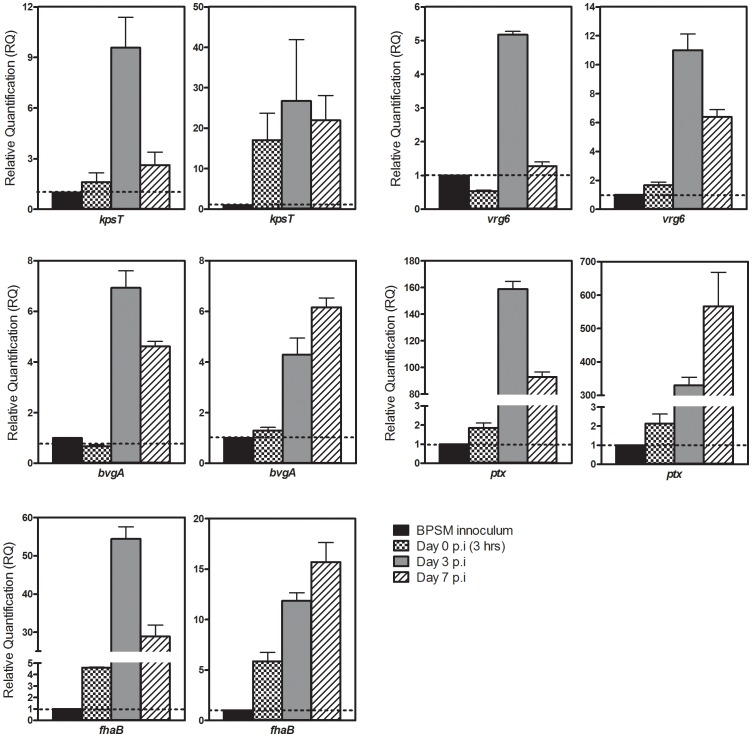
Relative transcriptional activity of vrgs and vags in BPSM bacteria recovered from mice lungs versus in vitro BPSM grown in virulent phase.Mice were infected intranasally with approx. 5×106 CFU of BPSM and the bacteria were recovered from the mice lungs at different time points (3 hours, day 3 and day 7 p.i.). Bacterial RNA extracted and purified from group of 4 mice were pooled and subjected to real-time PCR analysis using primers mapping in the kpsT, vrg6, bvgA, fhaB and ptx genes. RecA gene was used as the endogenous control. Results are expressed as the average RQ ± SD of triplicate versus BPSM inoculum. Dotted line represents RQ equal to 1 relative to BPSM inoculum. Mock-infected mice were used as negative control. The data obtained with two biological replicates are shown. Please refer to S1 Table for Pearson correlation scores between the two independent sets.